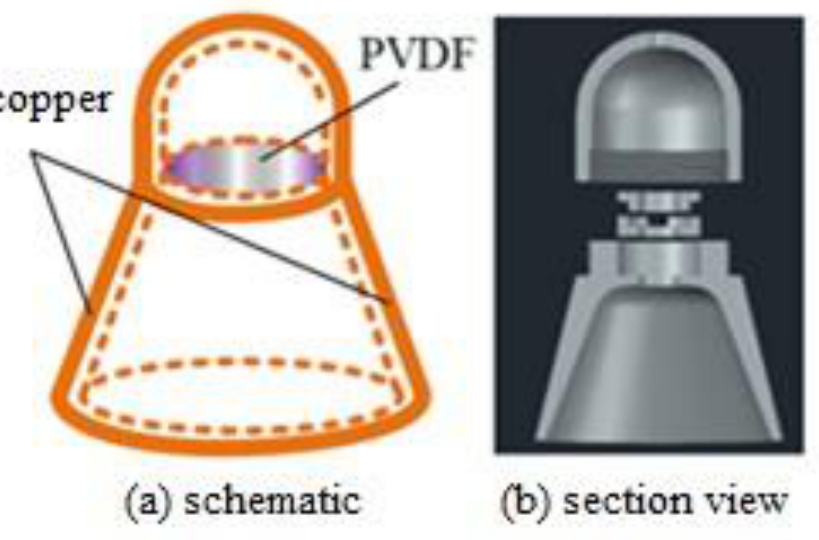
Figure 2. Fetal heart sound Figure 2. fetal heart sound sensor.